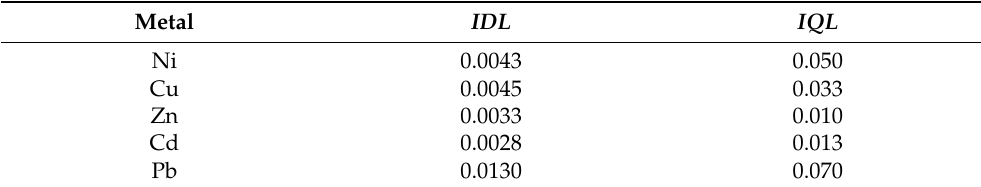
Table 4. The instrumental detection limits ( IDL ) and instrumental quantification limits ( IQL ) for